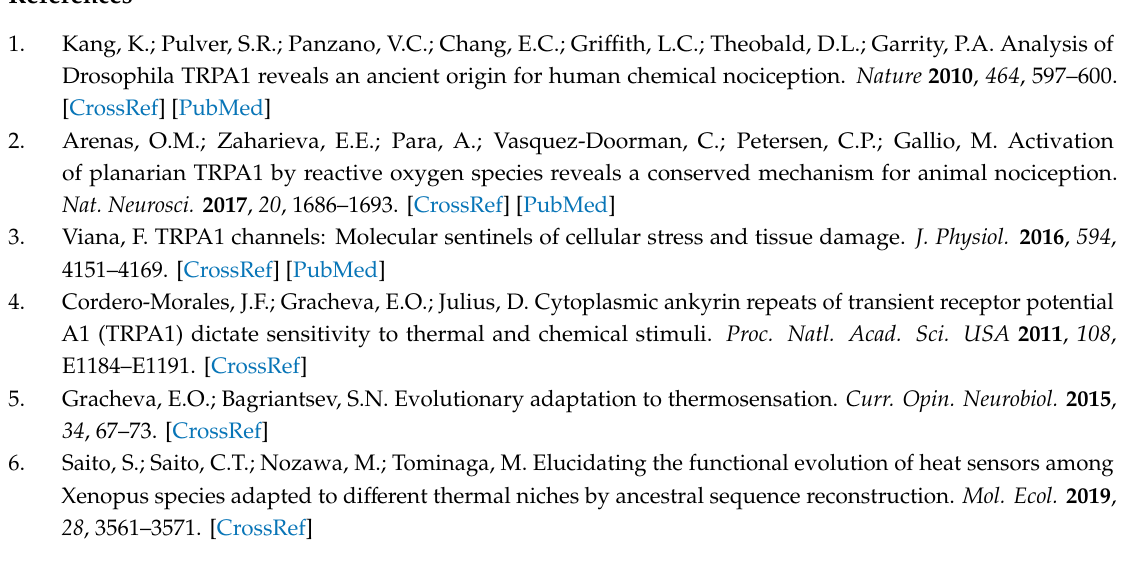
Figure S1: Species-specific involvement of a single residue in S5 in temperature sensitivity at close-to-saturation voltages, Figure S2: Screen for the non-homologous residues in the vicinity of V875, Figure S3: Functional screen of non-homologous residues in the vicinity of V875, Figure S4: Structural–Functional role of the C-terminal region, Figure S5: Both hTRPA1 and mTRPA1 exhibit heat-induced currents, Figure S6: Cold-induced currents in the mutants with slowed activation / deactivation kinetics, Figure S7: Voltage- and heat-activated currents from neuronal F11 cells expressing mTRPA1, Figure S8: TRPA1 is directly and reversibly activated by high noxious